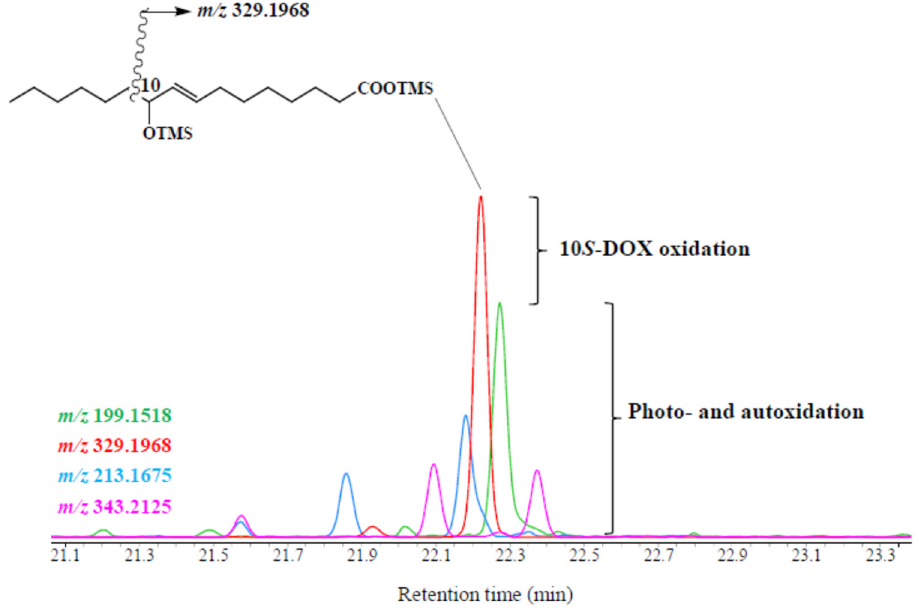
Figure 3. Partial ion chromatograms (at m/z 199.1518, 329.1968, 213.1675, and 343.2125) showing the presence of biotic and abiotic palmitoleic oxidation product trimethylsilyl derivatives (including the 10 S -DOX degradation product, 10 S -hydroxyhexadec-8( trans )-enoic acid) in superficial bottom sediment (0–1 cm) collected at Qikiqtarjuaq.